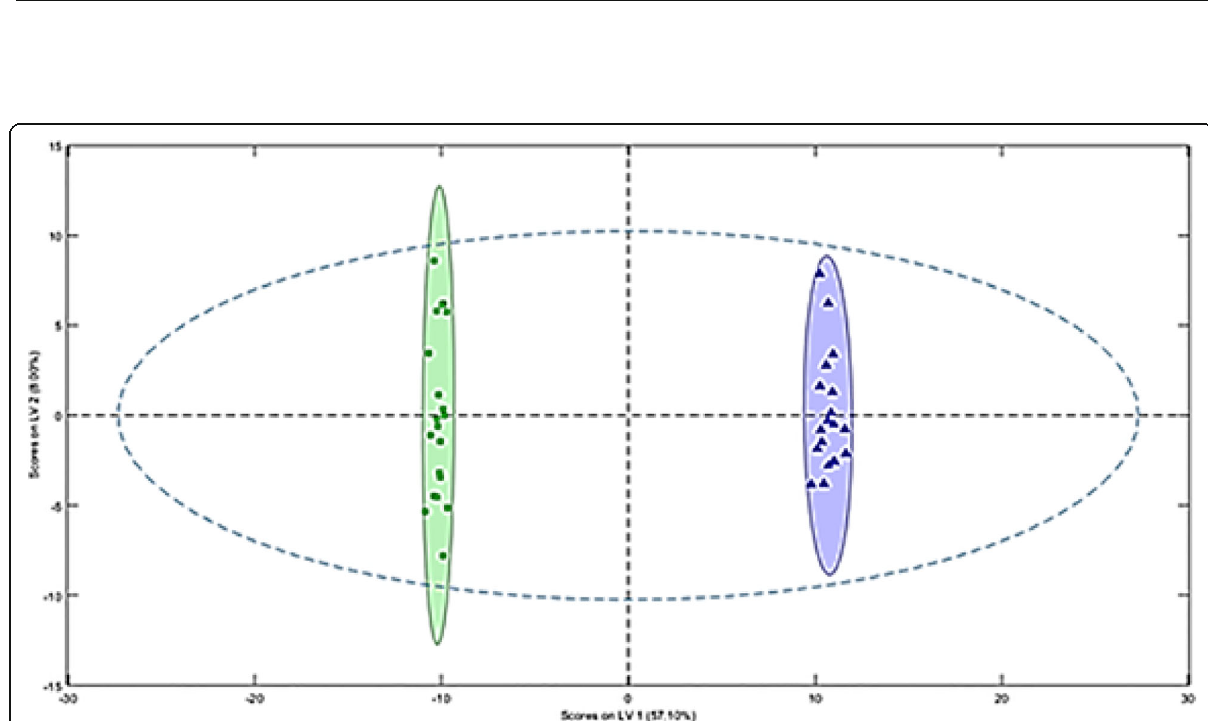
Fig. 2 Pathway analysis generated by MetaboAnalyst online. The major pathways varied in STEMI vs NSTEMI patient groups